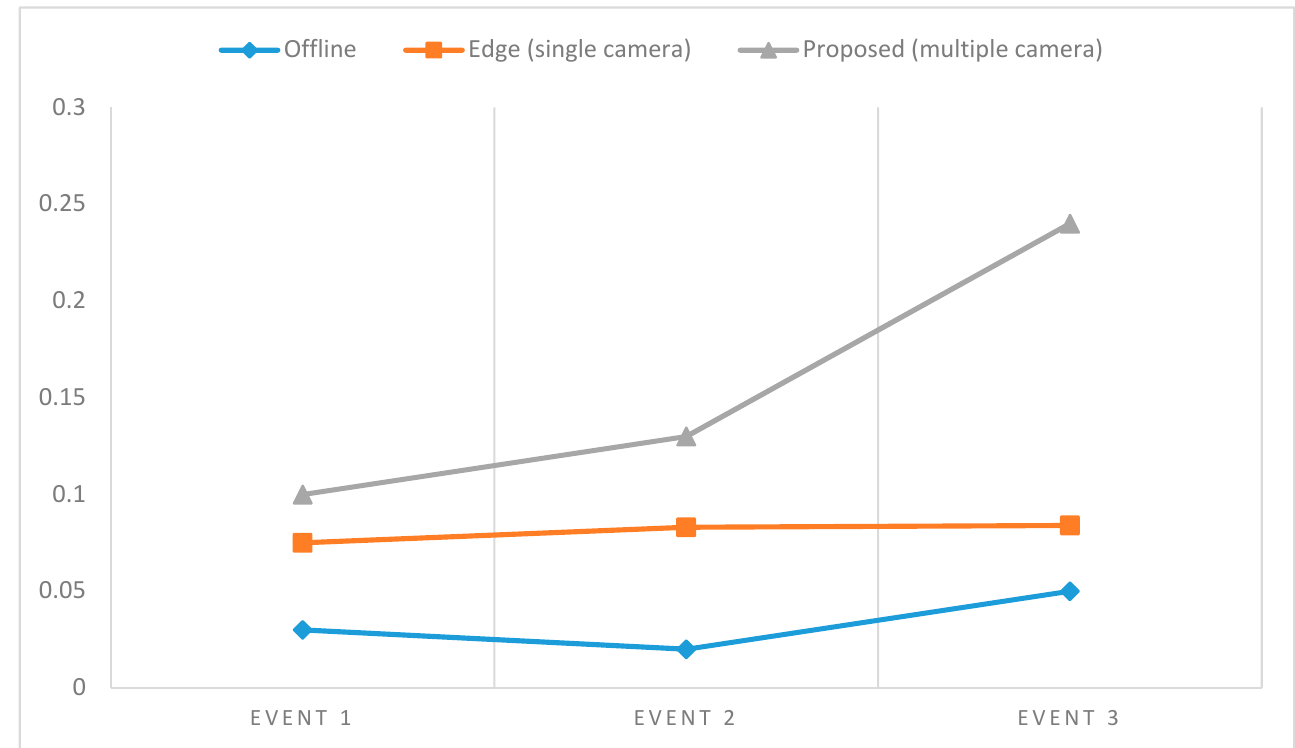
Figure 11. Relative latency values comparison of offline, edge, and the integrated architecture.